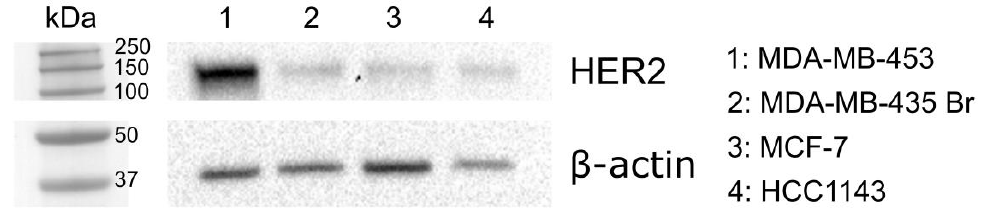
Figure 1. Western blot analysis of HER2 expression level of different cell lines. Equal protein amounts were run on Tris-tricine gel and blotted to PVDF membrane. As loading control, β-actin was used.